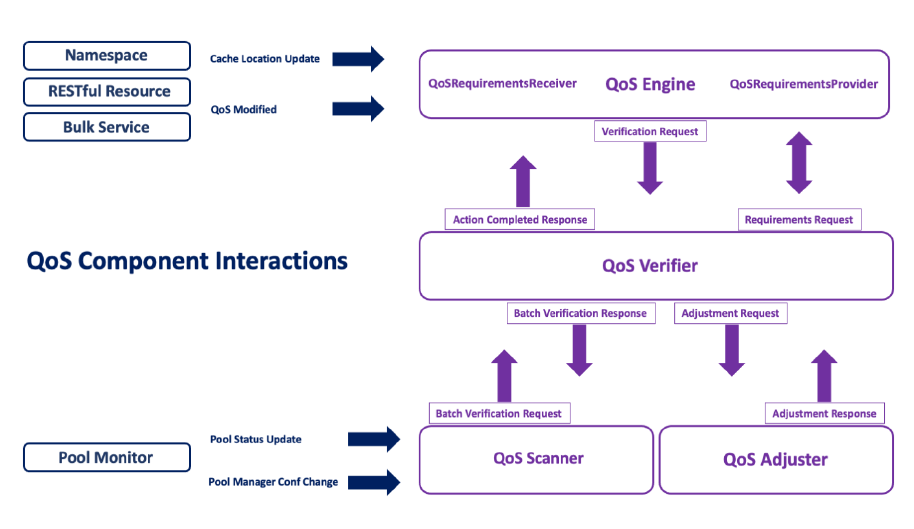
Figure 3. Resilience-to-QoS Mapping.